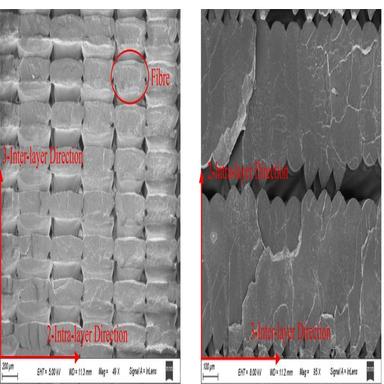
Micro-structure of FFF 3D printing PLA material under different magnifications.